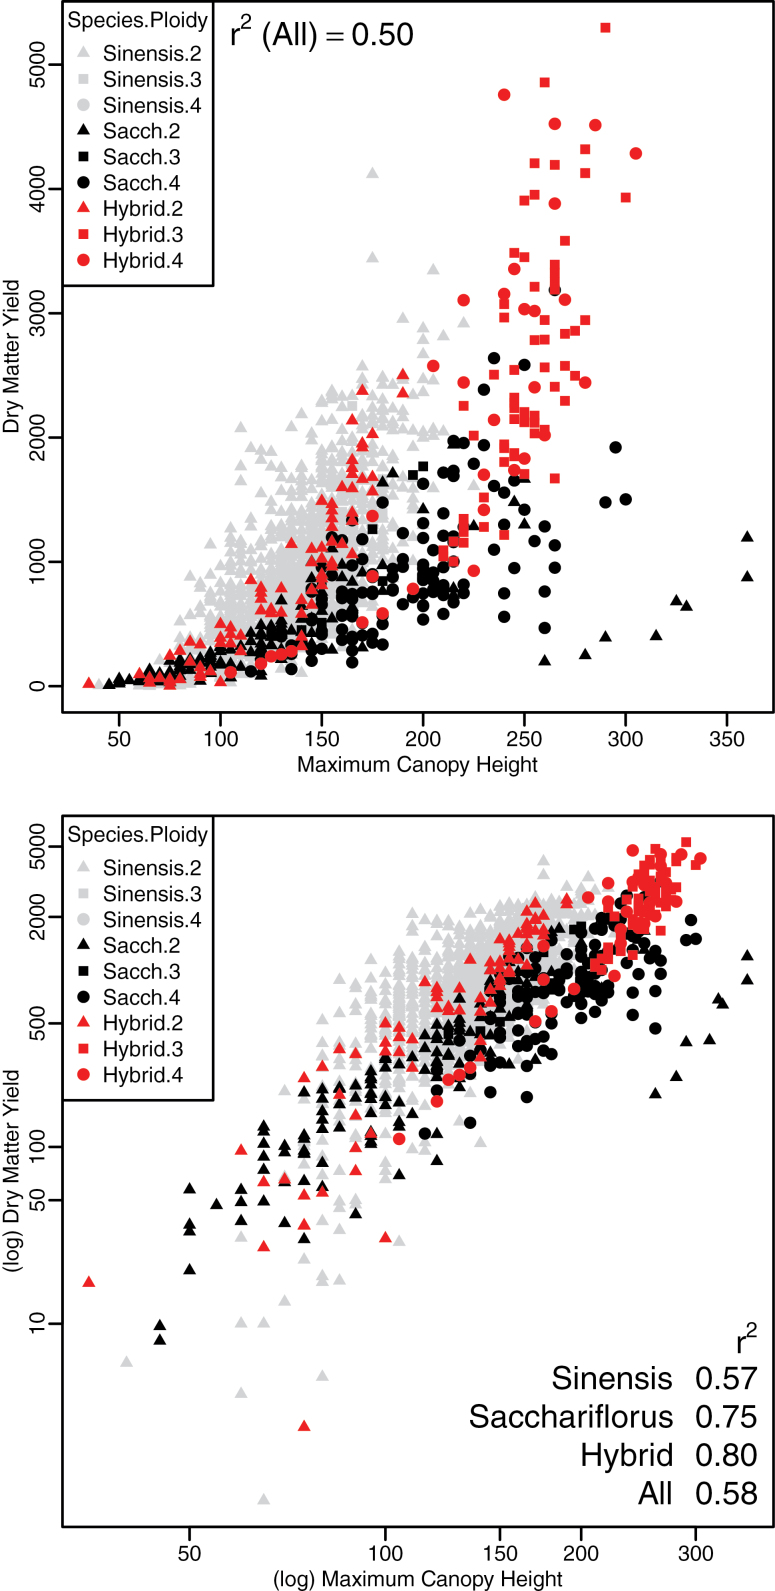
Pairwise trait plots between dry DMY and canopy height for all replicates for Y4 and Y5 for untransformed (upper plot) and log transformed (lower plot) data by species: M. sinensis (grey), M. sacchariflorus (black), and hybrid (red); and by ploidy: diploid (triangle), triploid (square), and tetraploid (circle).